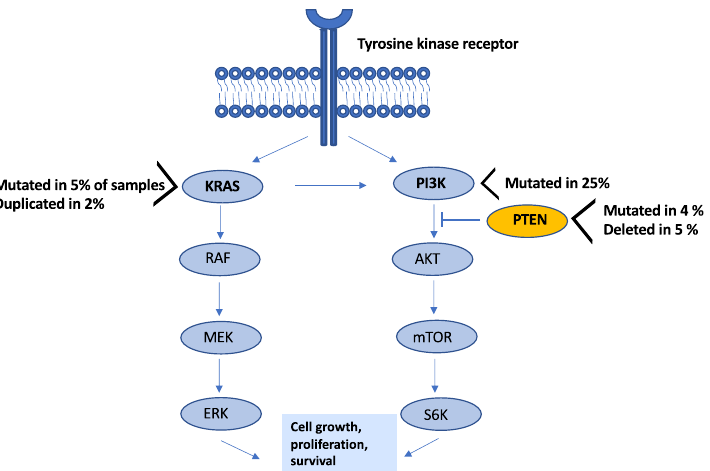
Figure 2. Illustration of the tyrosine receptor pathway activated in canine mammary tumors. Membranous tyrosine kinase receptors such as the HER2 receptor activated the downstream KRAS and PIK3CA pathway leading to downstream cellular proliferations and cell survival. Canine mammary tumors show evidence for activation of PIK3CA and KRAS as well as inactivation of PTEN leading to increased activity of this pathway. Illustration modified from Kim et al. 2020 24